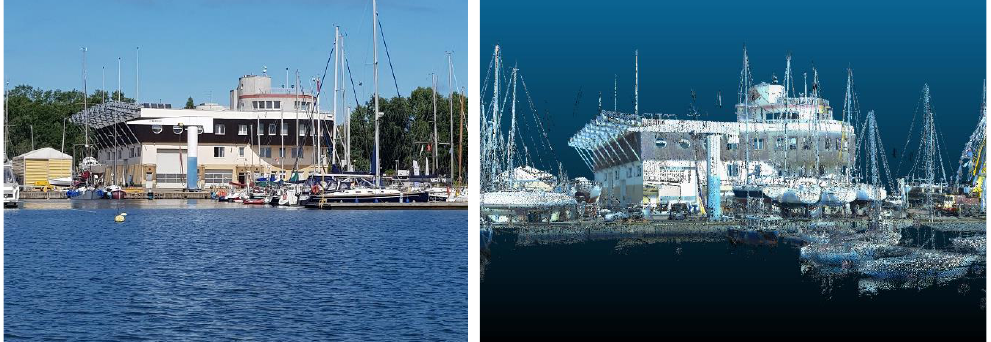
Figure 12. The image seen by the navigator and its construction on the basis of geospatial data from TLS cloud.